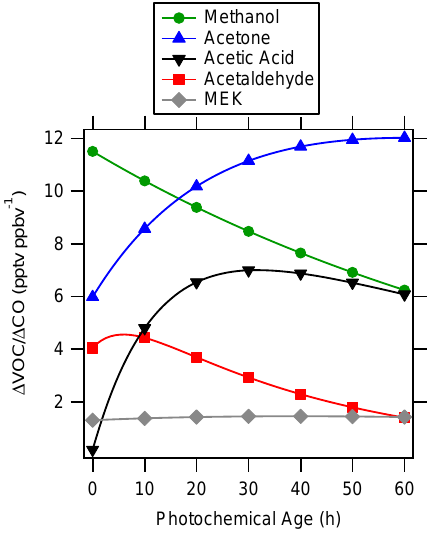
Fig. 2. Time evolution of oxygenated VOCs in a typical urban plume according to de Gouw et al. (2005). Curves are calculated using Eq. (5) and the numbers in Table 1 of de Gouw et al.